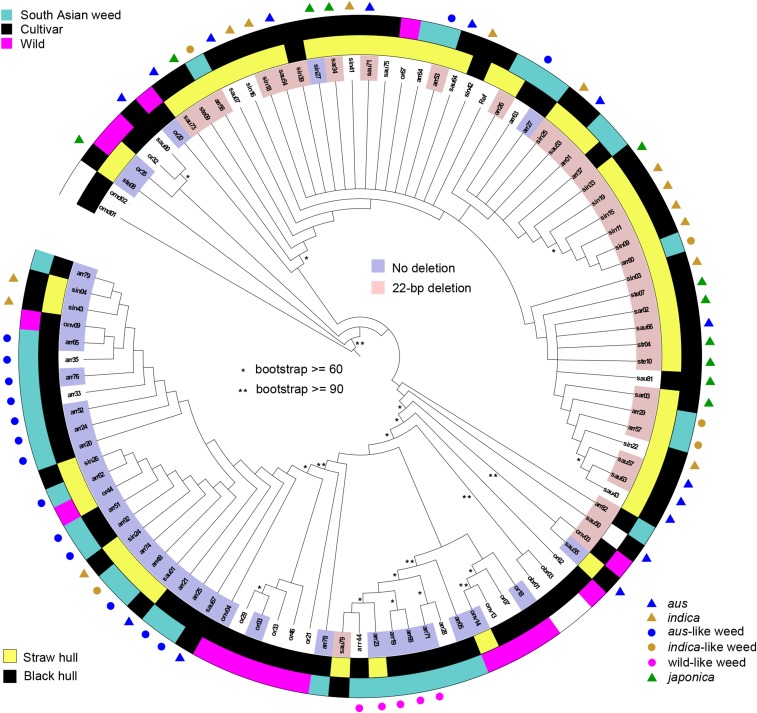
Neighbor joining (NJ) tree of Bh4 haplotypes. The color range indicates the two major InDel alleles of Bh4; the inner ring indicates the hull color. The outer ring and the bullets indicate Oryza groups, as labeled in the key. Unmarked weeds are admixed according to results of Huang et al. (2017). Asterisks on branches indicate bootstrap values as labeled.